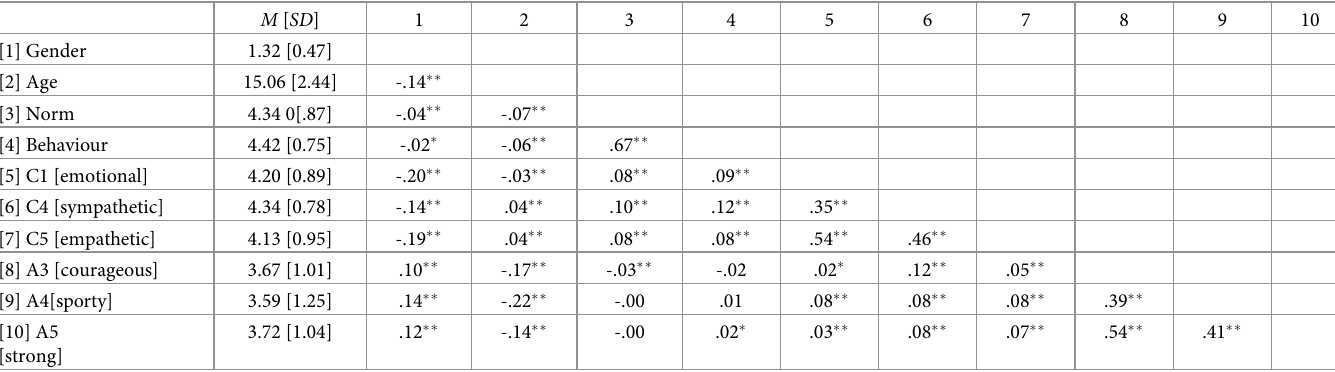
All scales range from 1 indicating the lowest value to 5 indicating the highest value. �� p < .01. � p < .05.